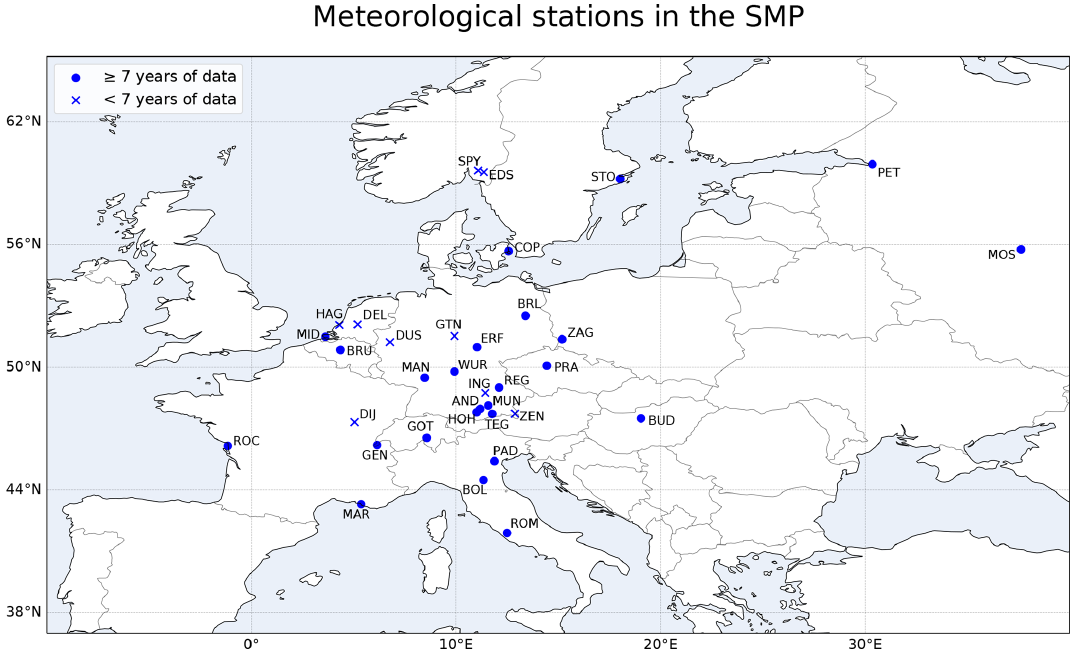
Figure 1. Network of stations that contributed to the Ephemerides of the Societas Meteorologica Palatina – see Table 1 for abbreviations. Dots represent those stations that contributed for 7 or more years of the total 12-year period from 1781 to 1792; locations with a cross are stations that sent measurements for fewer than 7 years. This distinction is made to broadly convey the varying extent of the stations’ participation. Not shown on the map are the stations at Cambridge (US), Godthaab (GL), and Pyshminsk